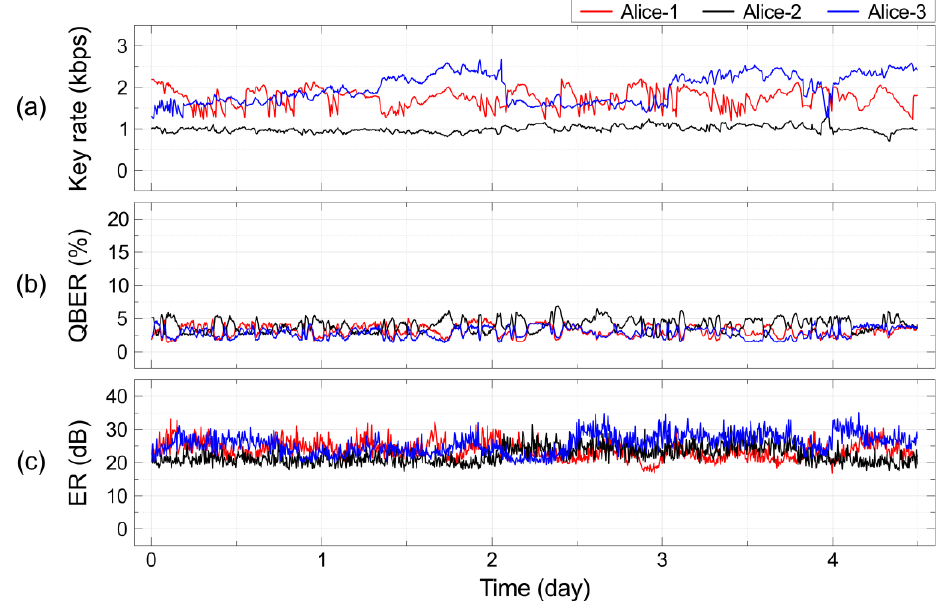
Figure 4. Experimental results of the field test: ( a ) Sifted key rates; ( b ) Quantum bit error rates (QBERs); ( c ) Extinction ratios (ERs) of the MZMs. The red, black and blue solid lines are the results of Alice 1 – 3, respectively.